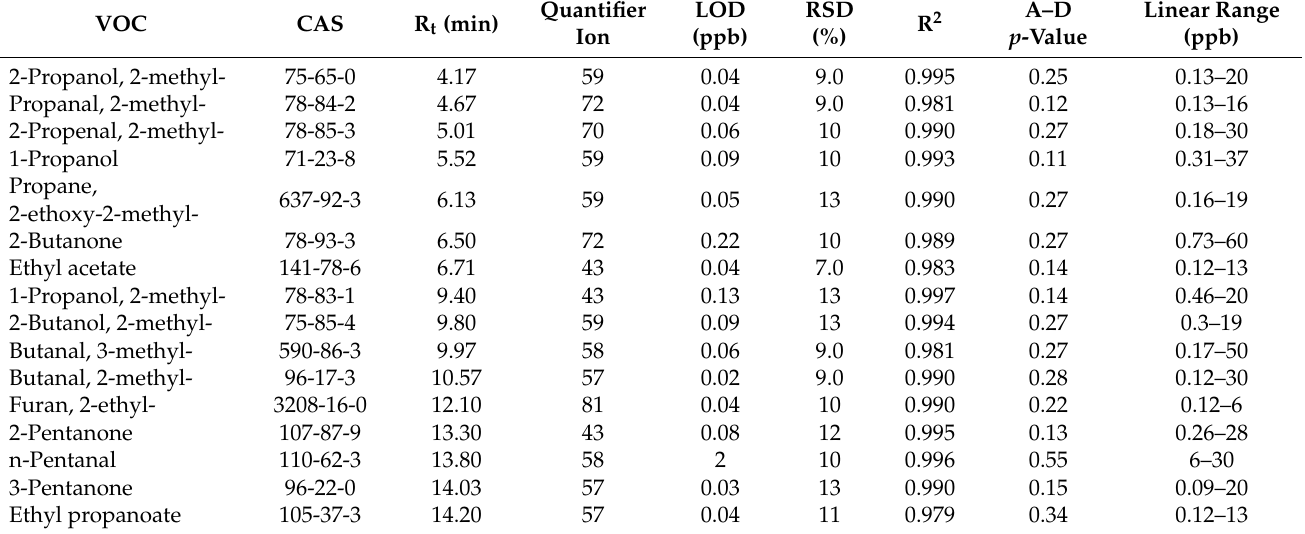
Table 1. Retention times (R t ) (min), quantifier ions, LODs (ppb), RSDs (%), coefficients of variation (R 2 ), Anderson-Darling normality test p -values (A–D) and linear ranges (ppb) for compounds of interest. Compounds are ordered with respect to increasing retention